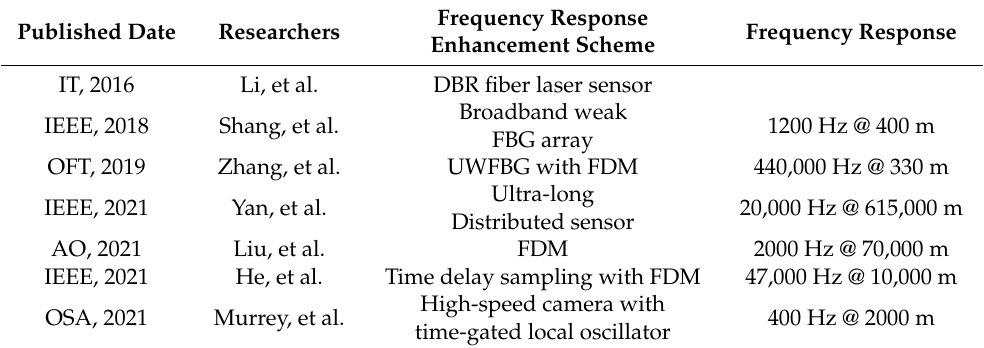
Table 4. Research progress for frequency response